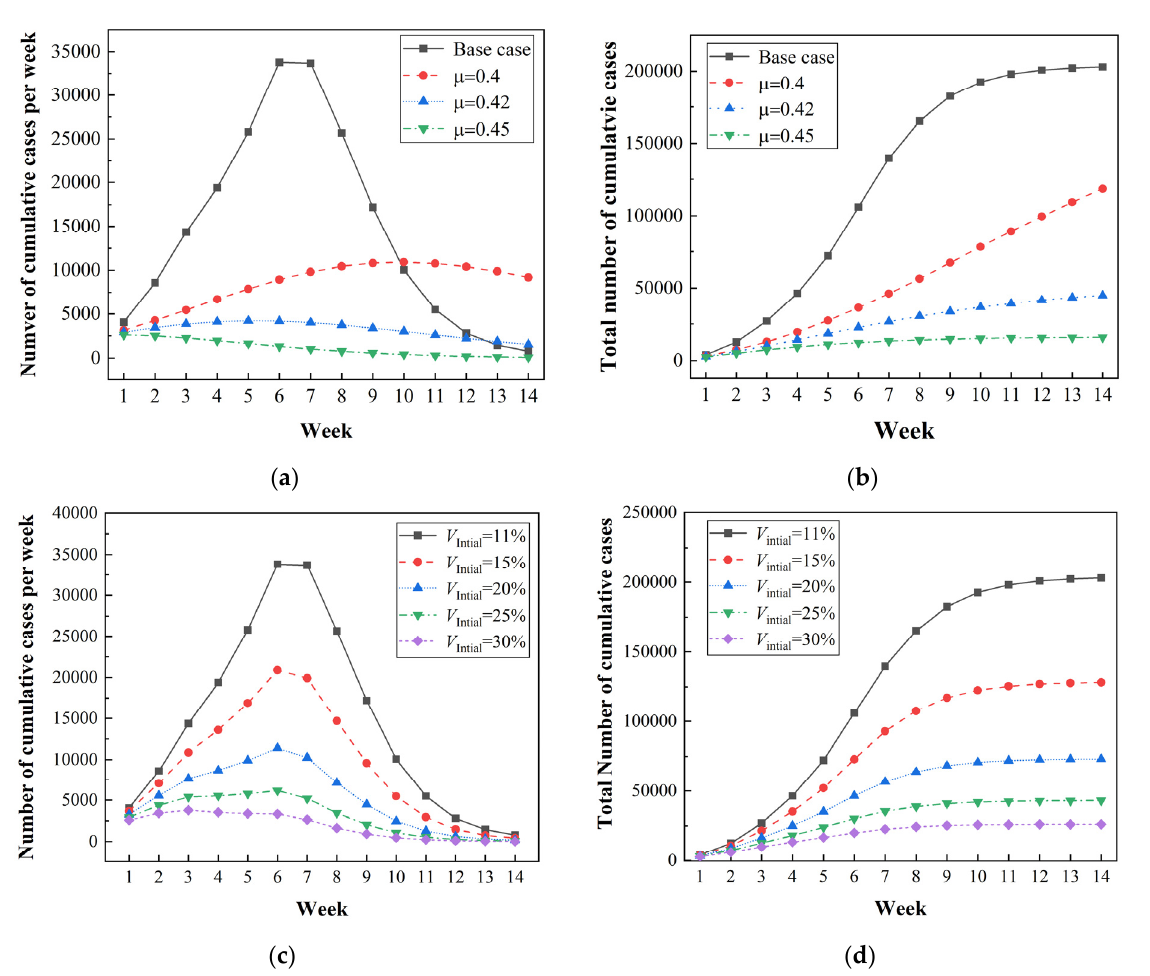
Figure 10. Simulated results under the implementation of Measure C and Measure D, where the transmission rate β = 0.6 is used: ( a ) The cumulative number of cases per week under Measure C; ( b ) the total number of cumulative cases under Measure C; ( c ) the cumulative number of cases per week under Measure D; ( d ) the total number of cumulative cases under Measure D.